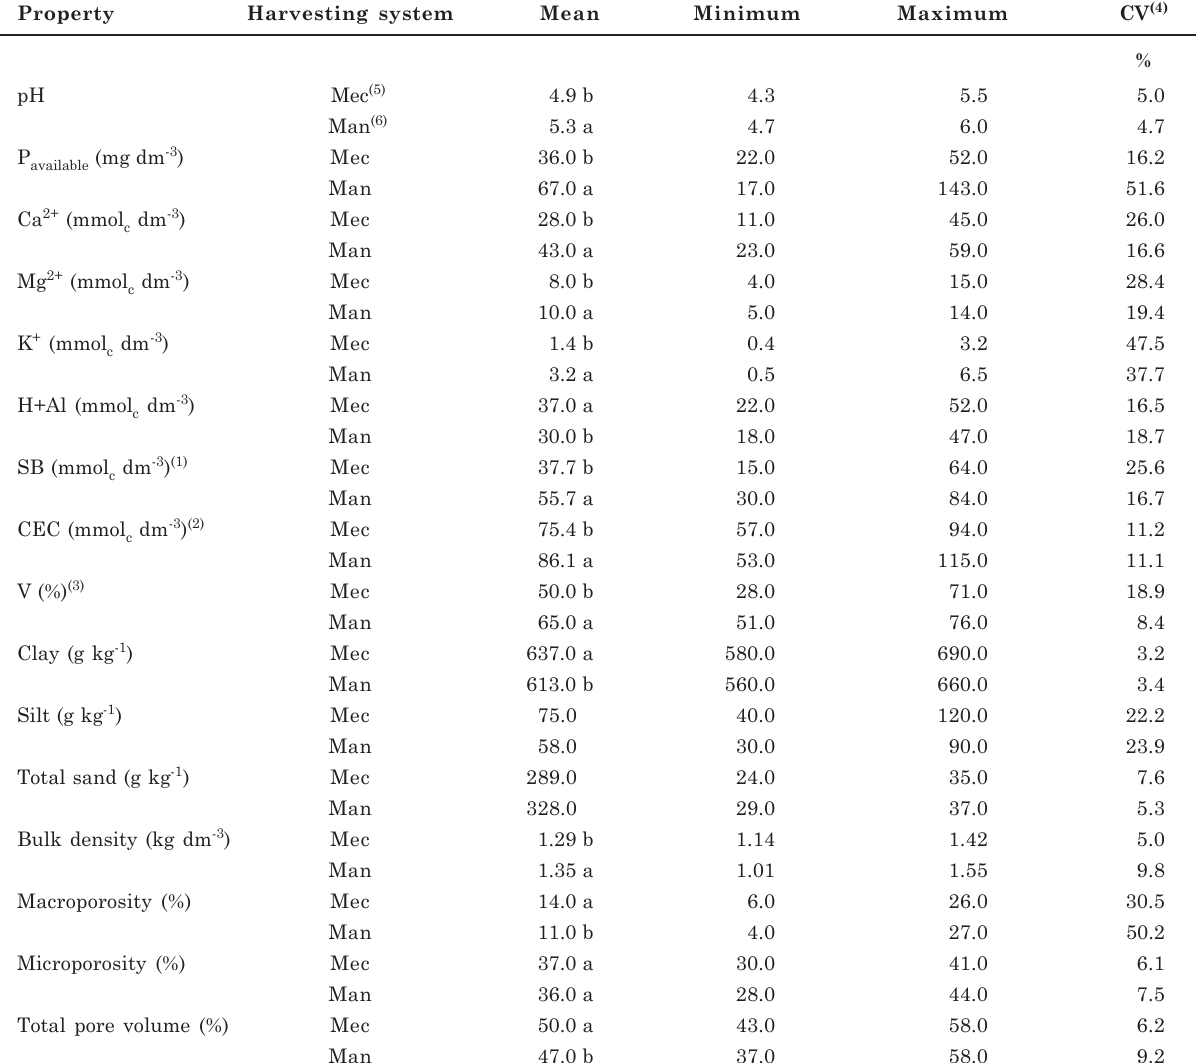
Table 1. Characterization, mean, maximum and minimum values; and coefficient of variation properties of chemical, grain size and physical of the soils in the two zones under